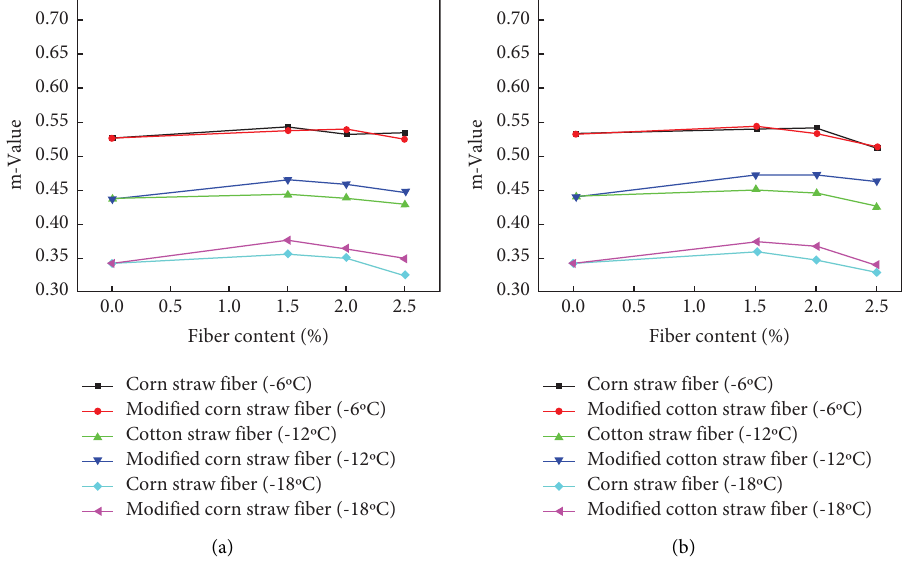
Figure 8: Efects of temperature and fber content on m -value of straw fber asphalt binder. (a) Corn straw fber. (b) Cotton straw